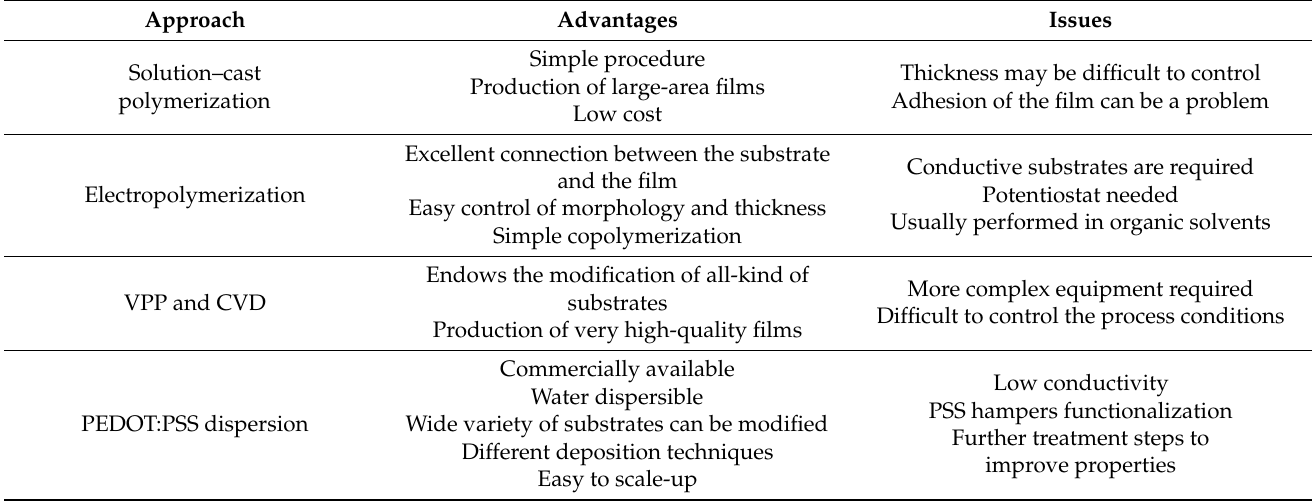
Table 1. Main advantages and disadvantages of the PEDOT and PEDOT:PSS production methods.